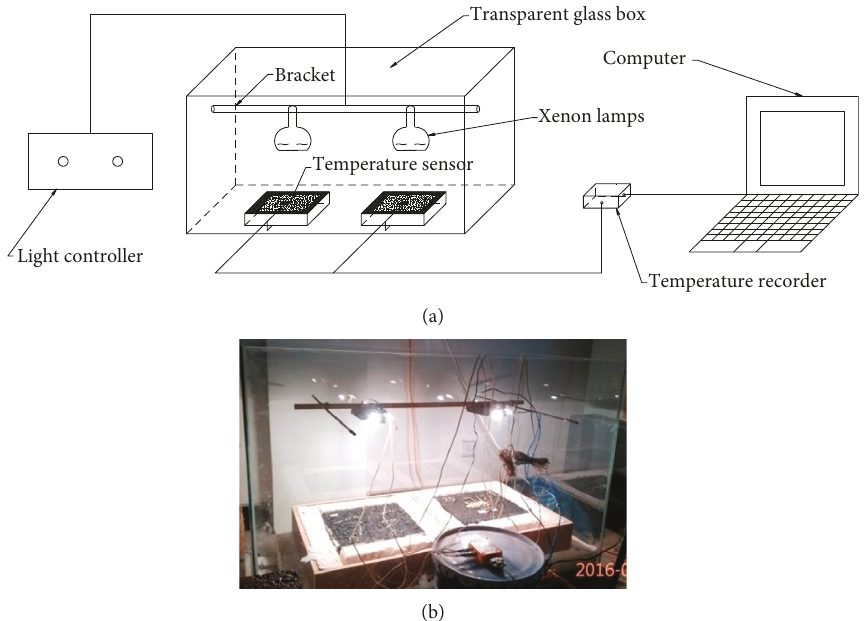
Figure 2: Test system of indoor illumination. (a) Schematic diagram of the illumination test and (b) light testing apparatus.